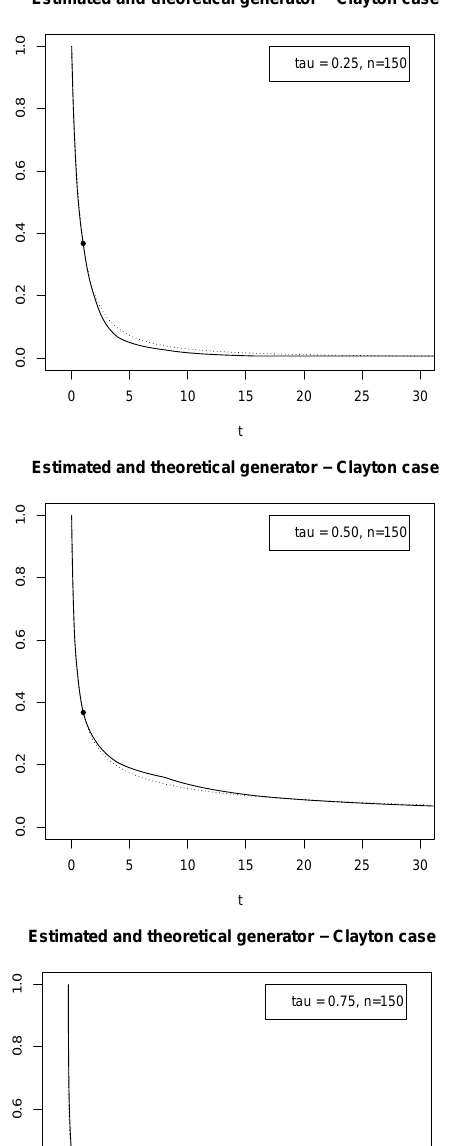
= 0 . 25 , 0 . 5 and 0 . 75 . Size of simulated samples n = 150 (left column) as in Definition 4.4 (full line). The theoretical standardized Clayton-generator, y ( t ) ( 0 )